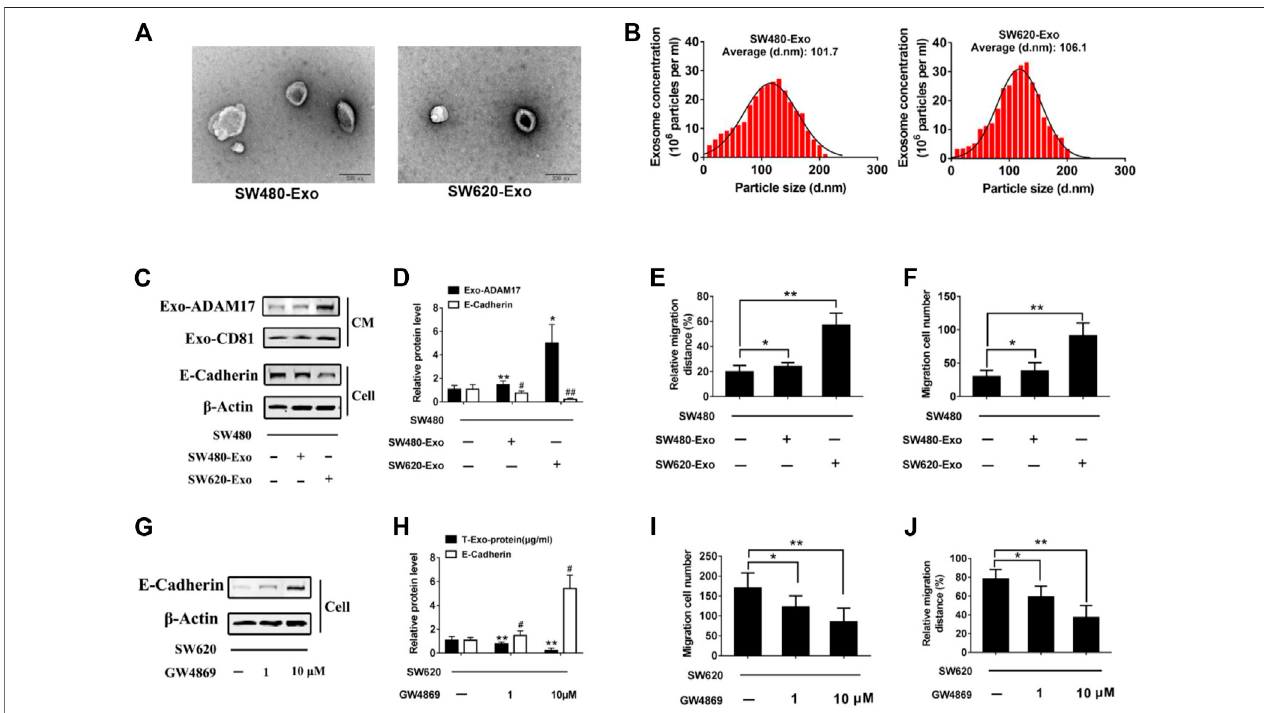
FIGURE2| ExosomalADAM17 enhancesthemigratorypropertiesofCRCcells.Characterization ofCRC cell-derived exosomes. (A) Electron microscopeimages ofexosomesisolatedfrom theCM ofcultured SW480and SW620 cells. Scalebar,200 nm. (B) Nanoparticle tracking analysisofisolatedexosomes. (C,D) SW480 cells were treated with SW480-derived exosomes (SW480-Exo) and SW620-derived exosomes (SW620-Exo) at 50 µg (10 μ g/ml) per 1 × 10 5 cultured cells. Exosomes were collected,cellswerelysed,andproteinlevelswerefurthercalculatedviagrayanalysis(thetotalexosomalproteinwassetastheinternalcontrolforexosomalprotein analysis, ß -actin was set as the internal control for cells, n (cid:2) 6). (E,F) Changes in migration were measured via transwell and wound scratch assays using SW480 cells treatedwithSW480-ExoandSW620-Exo( n (cid:2) 6). (G,H) SW620cellsweretreatedwithdifferentconcentrationGW4869,andthetotalexosomalproteinaswellascellular E-cadherin levels were calculated ( n (cid:2) 6). (I,J) Changes in migration were measured via transwell and wound scratch assays using SW620 cells treated with GW4869 ( n (cid:2) 6). Data are expressed as means ± SDs. * or #, p < 0.05; ** or ##, p <